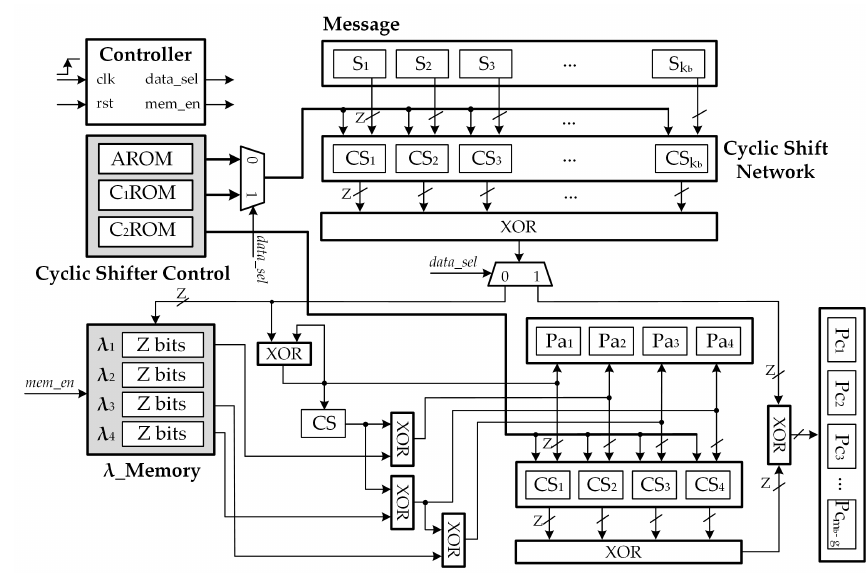
Figure 4. Low-complexity high-throughput encoder architecture for 5G NR QC-LDPC